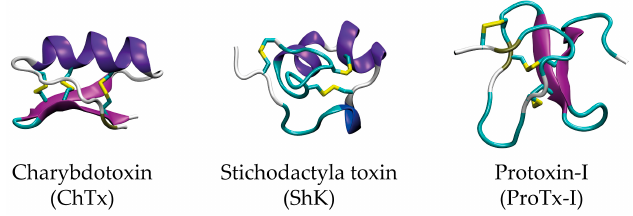
Figure 1 : Structures of the disulfide-rich venom peptides Charybotoxin (ChTx, PDB-id 2CRD), Stichodactyla toxin (ShK, PDB-id 1ROO), and Protoxin-I (ProTx-I, PDB-id 2M9L). The well-defined secondary structure is stabilised by one or more disulfide bonds (yellow).